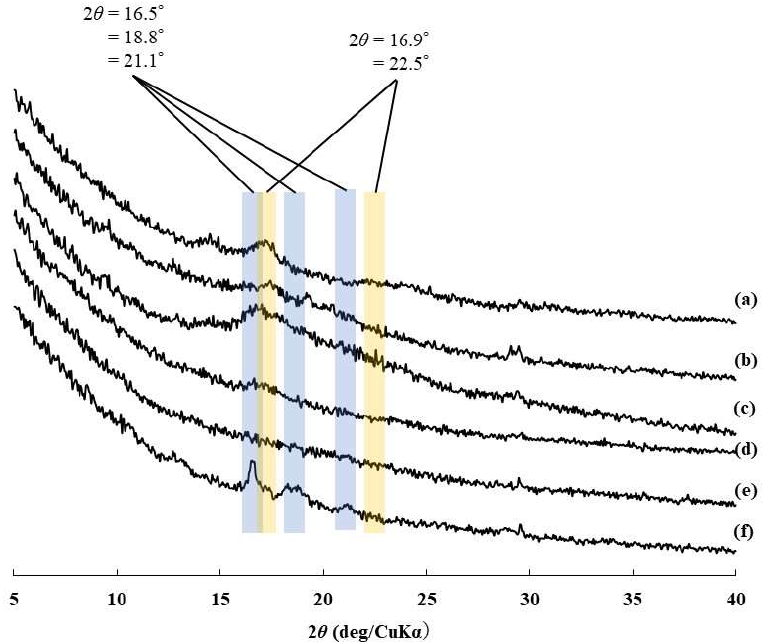
Figure 4. XRD profiles of (( a ), entry 1 in Table 1) amylose-, (( b – e ), entries 2–5 in Table 1) P2D-amylose-, and (( f ), entry 6 in Table 1) 2-deoxyamylose-grafted PGAs.